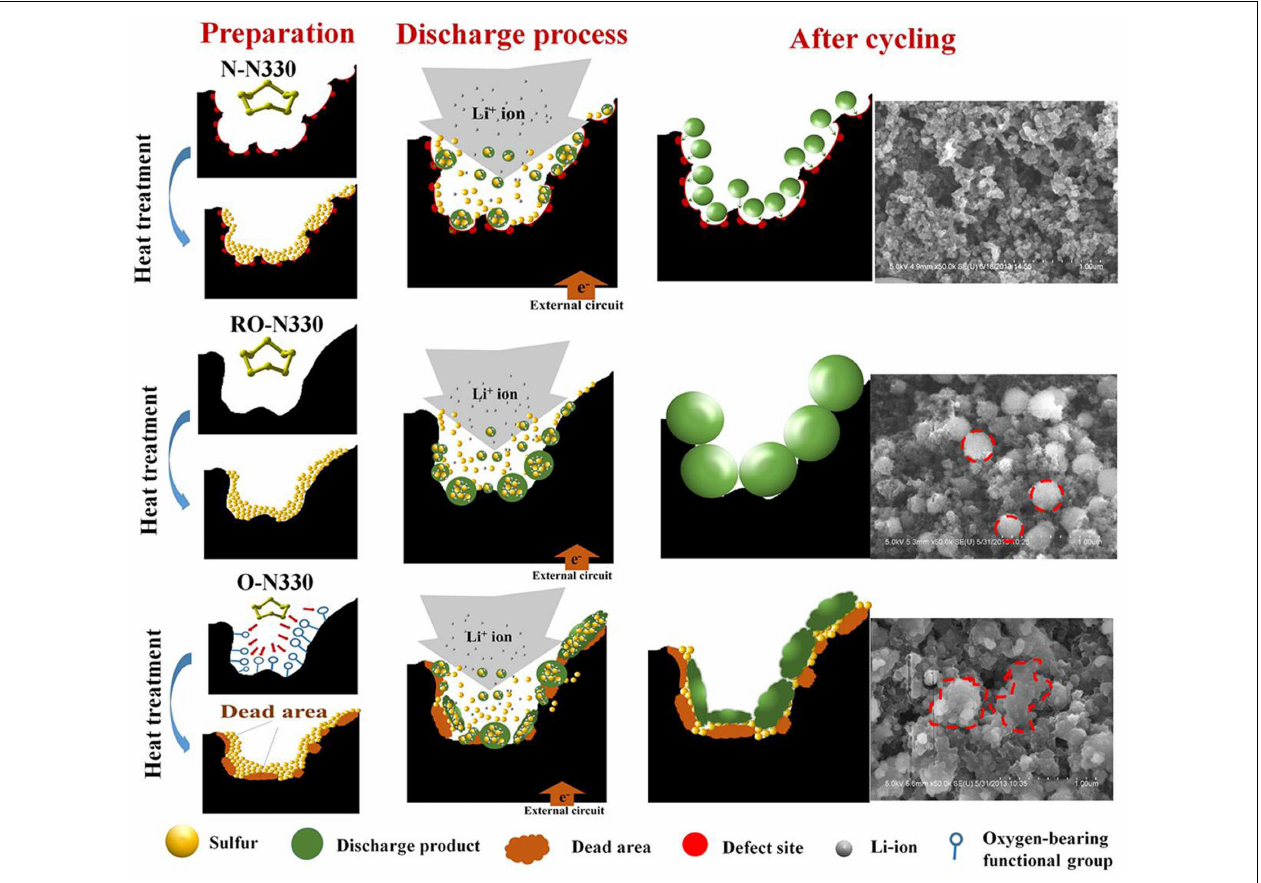
FIGURE 4 | Proposed mechanisms of sulfur–carbon blacks in synthesis and electrochemical reaction (Li et al., 2014a)